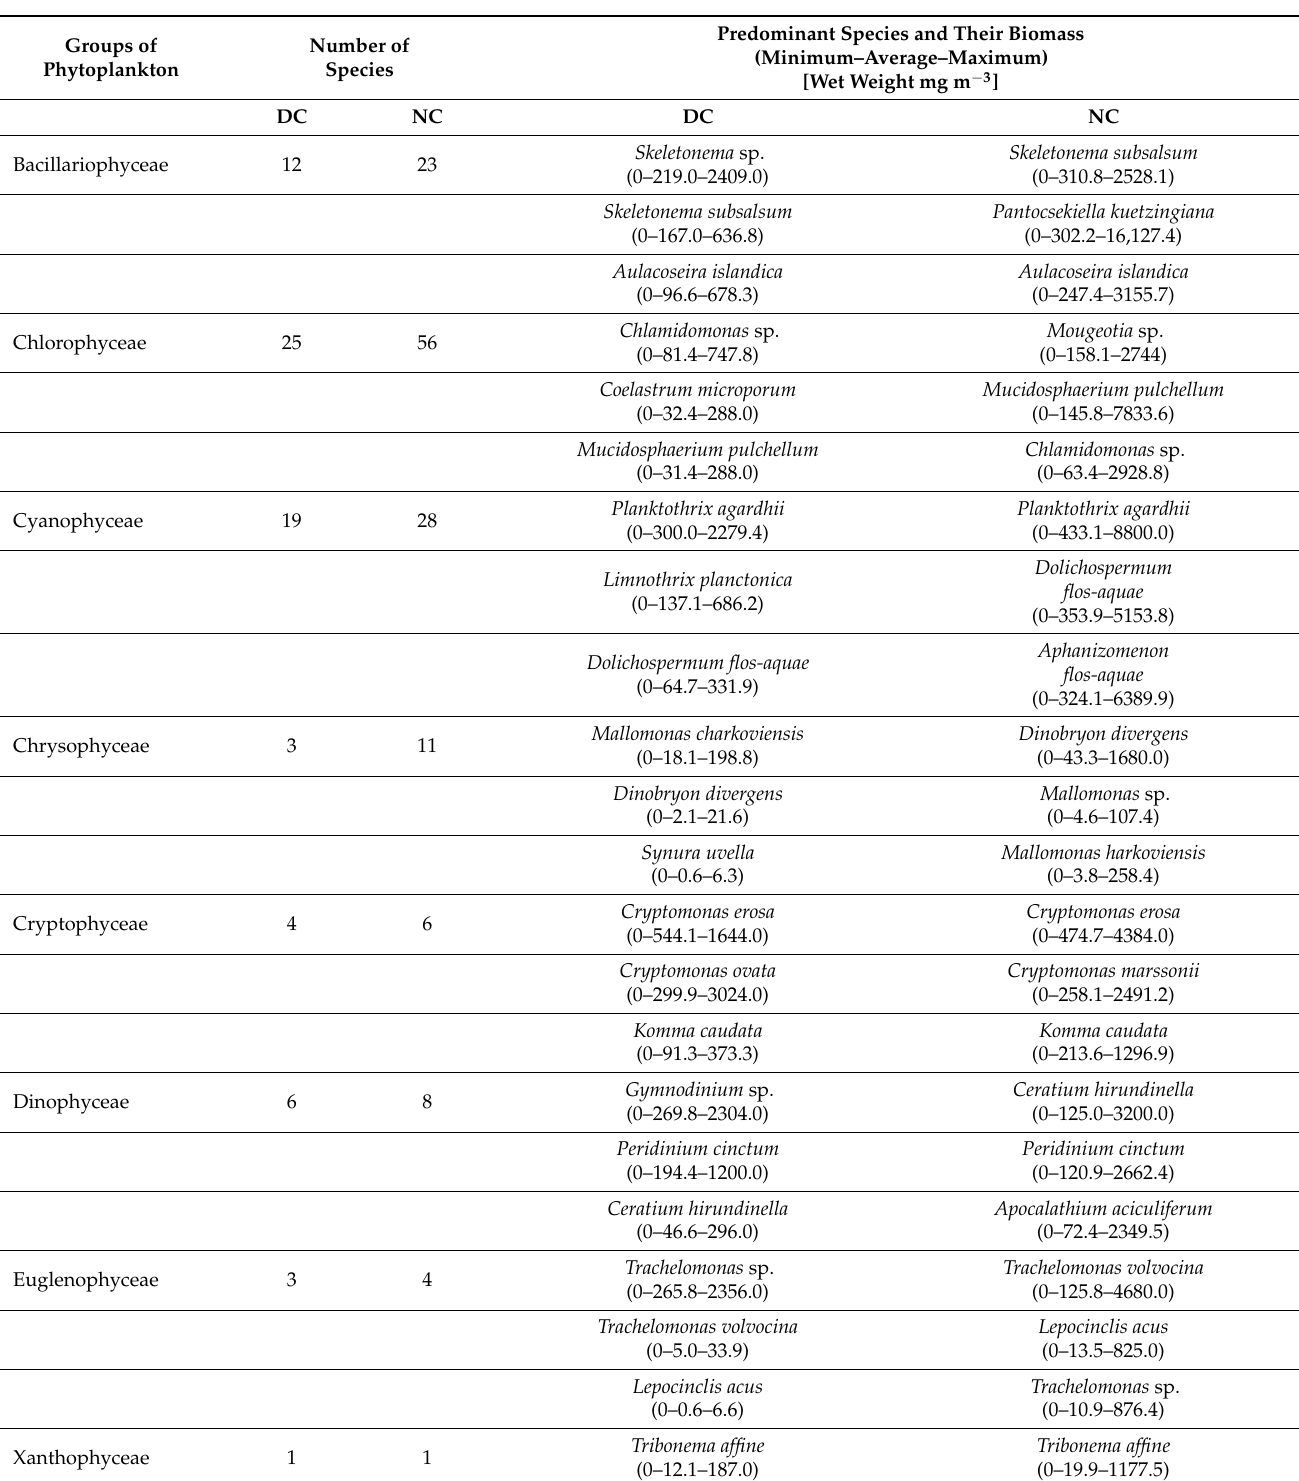
Table 2. Species richness and the most dominant species in the phytoplankton biomass in the Neva Estuary during the construction of new port facilities (DC) and during the period when this construction was not carried out